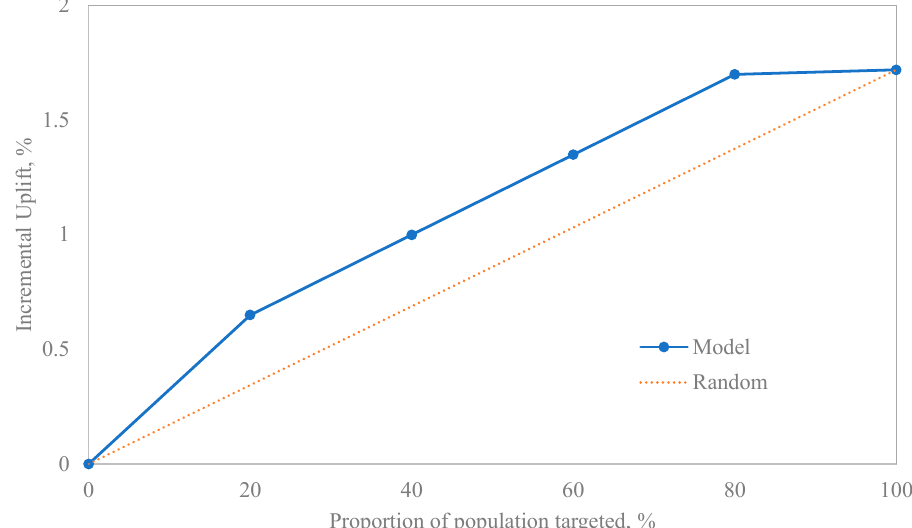
Figure 4. Qini curve for Uplift modeling for the validation data—indoor benzene distribution.